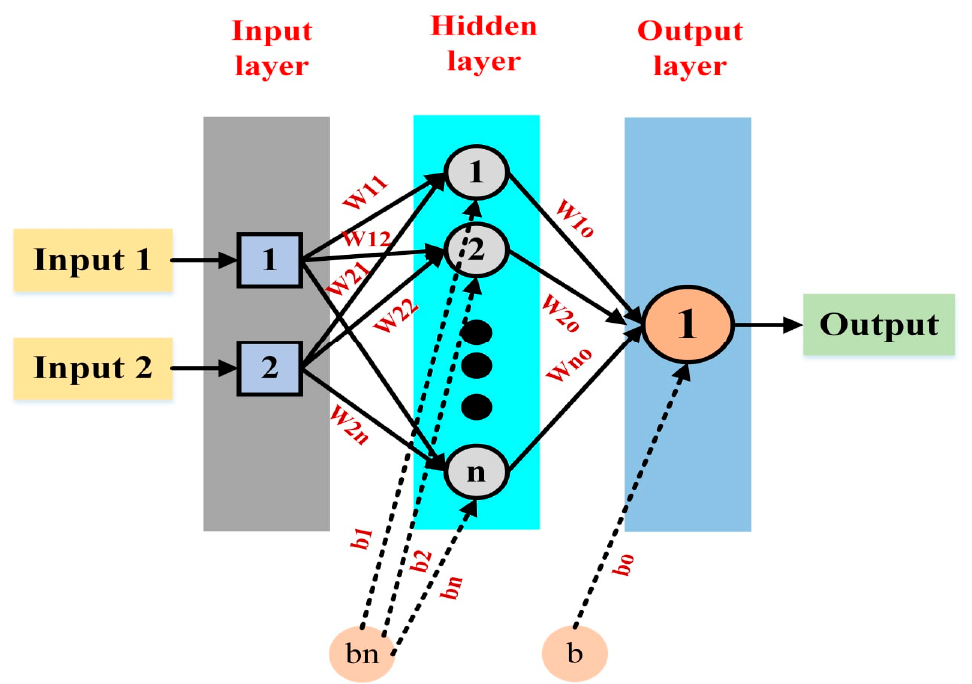
Figure 8. The schematic diagram for an ANN model.